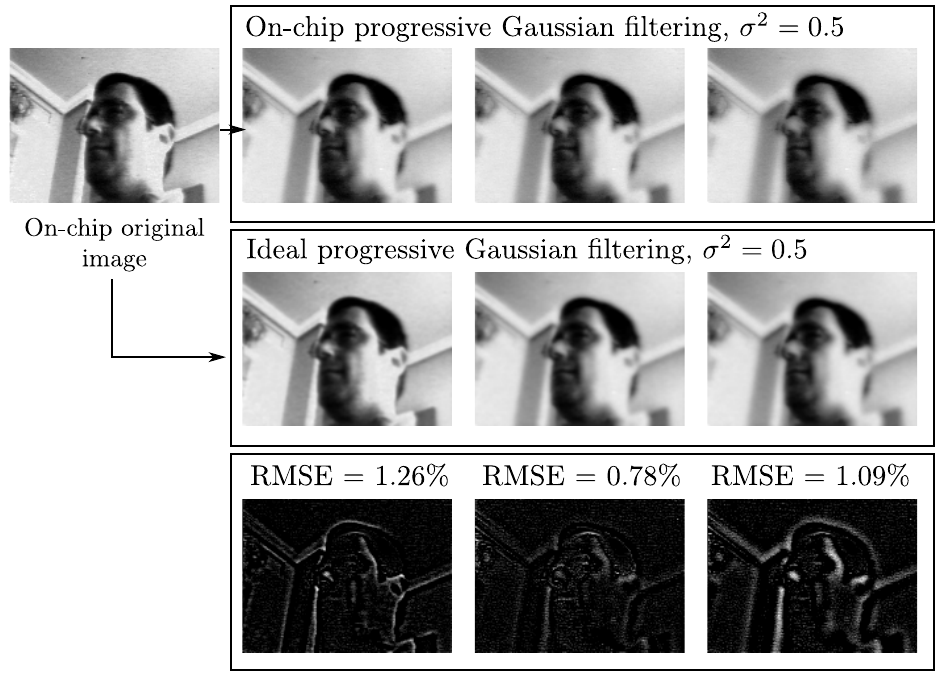
Figure 13. On-chip focal-plane Gaussian filtering and comparison with the corresponding off-chip ideal